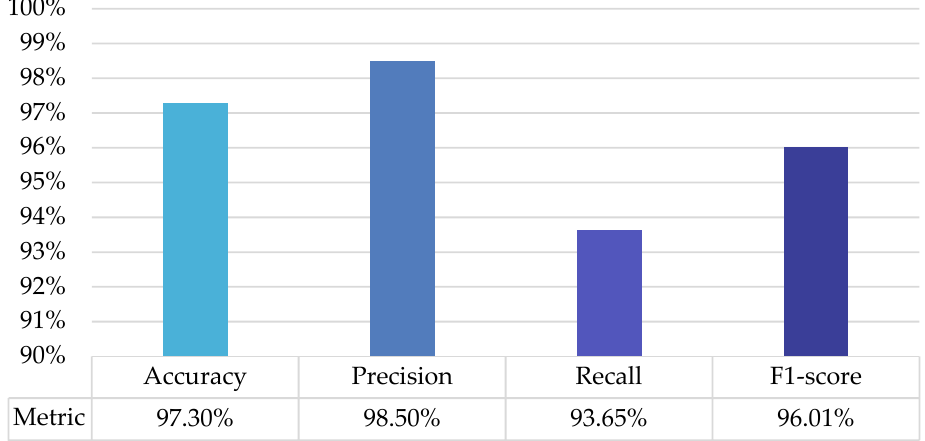
Accuracy Precision Recall F1-score Metric Figure 10. Performance of the unsupervised multi-autoencoder Figure 10. Performance of the unsupervised multi-autoencoder approach.